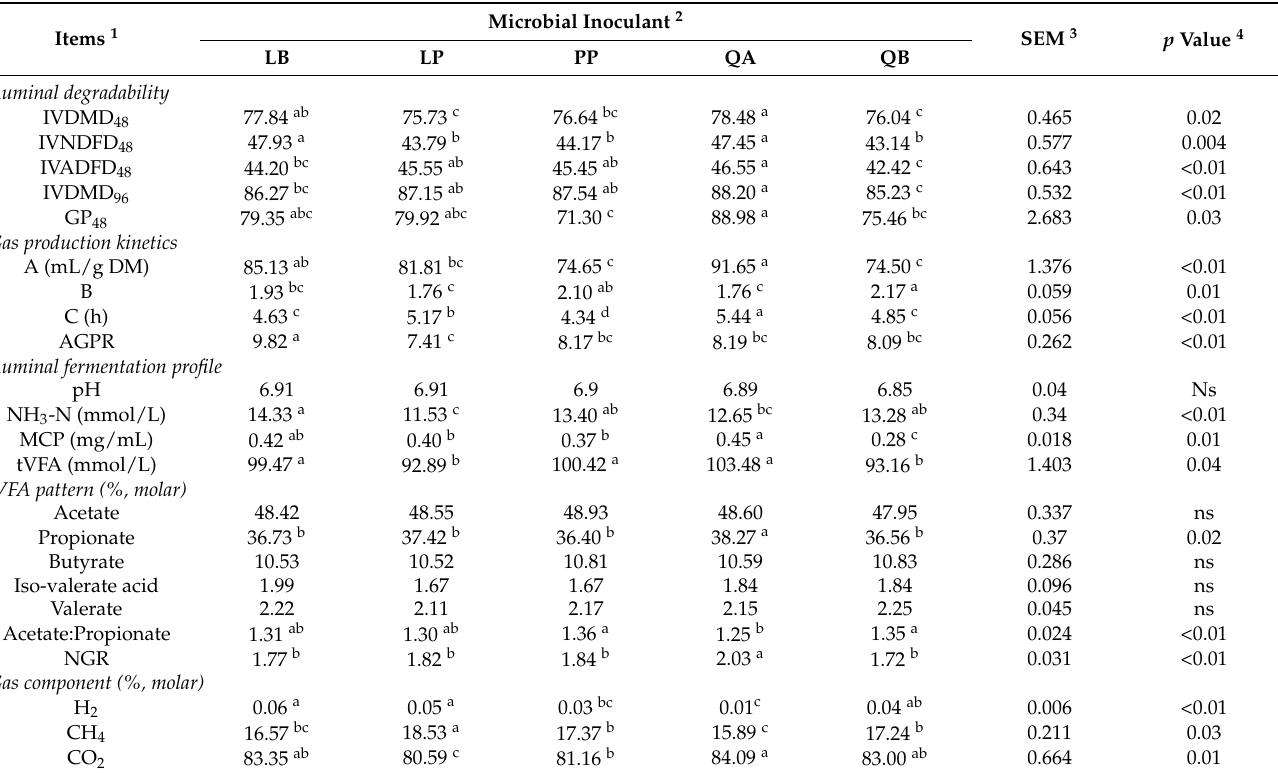
Table 5. In vitro dry matter disappearance and kinetics of gas production of 60 day ensiling whole corn silage incubated with rumen fluids obtained from dairy